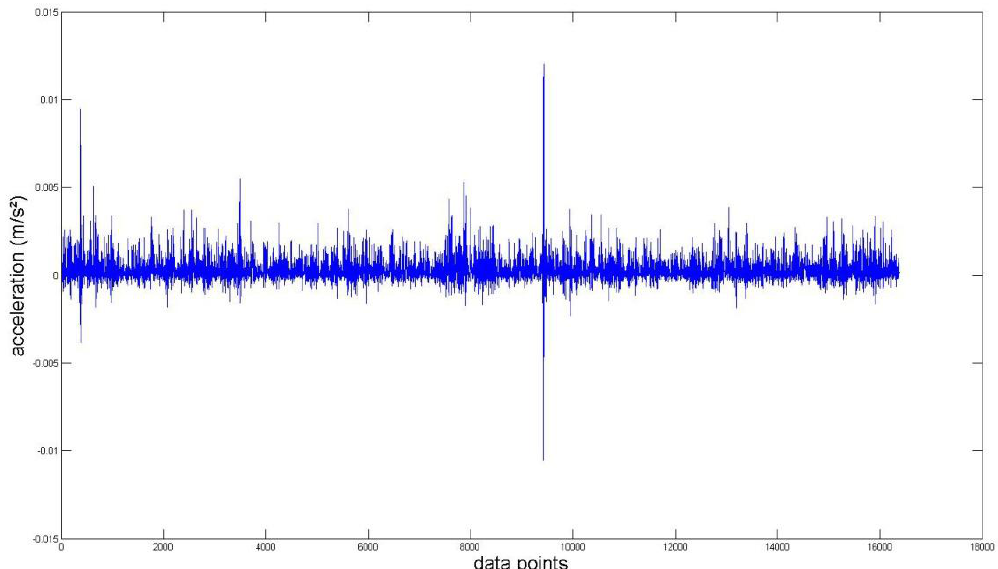
Figure 8. Vibration data points after applying only TKEO signal processing on a damaged bearing (Case